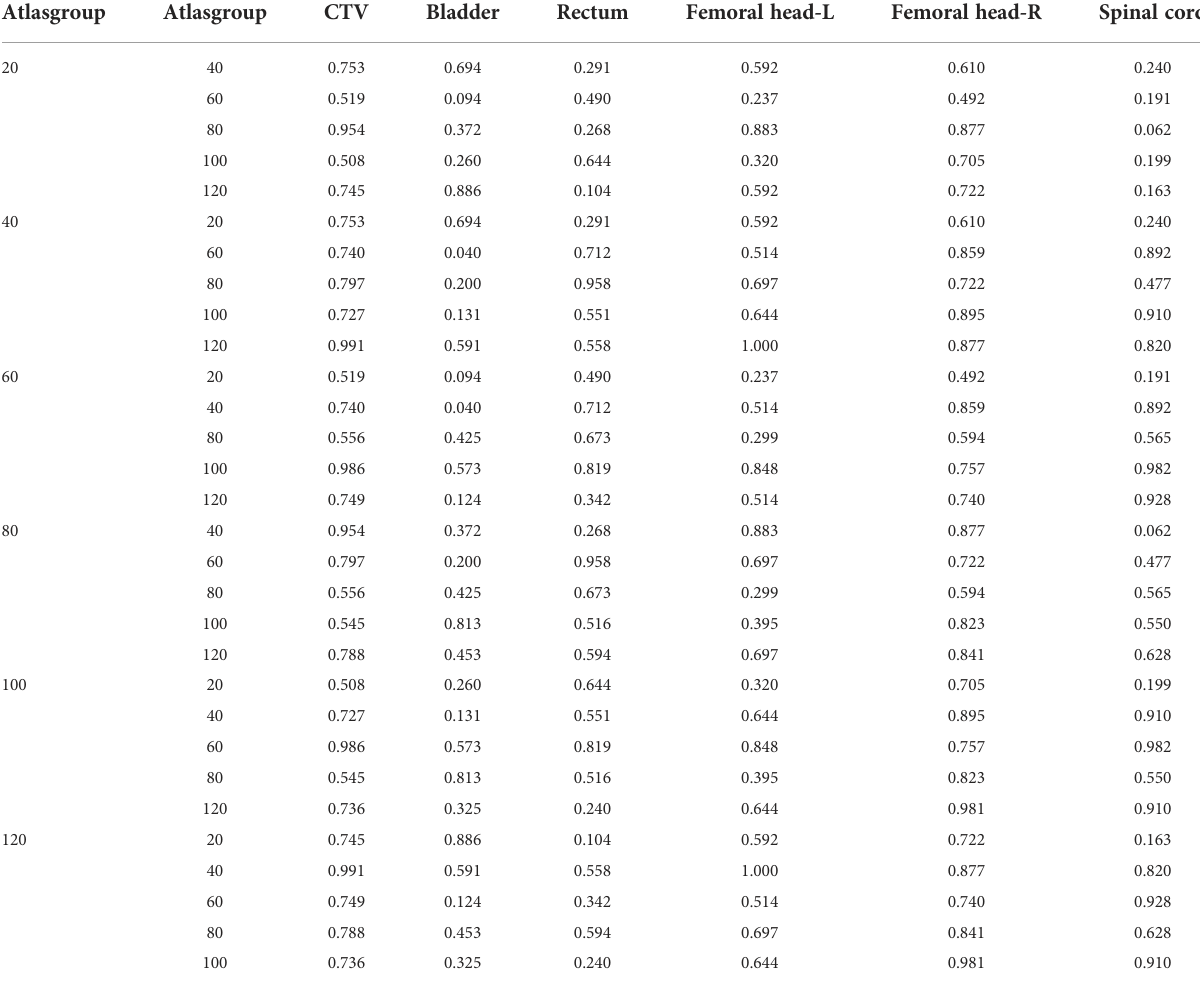
TABLE 5 Results of post-hoc least signi fi cant difference (LSD) with DSC value among different atlas library groups.